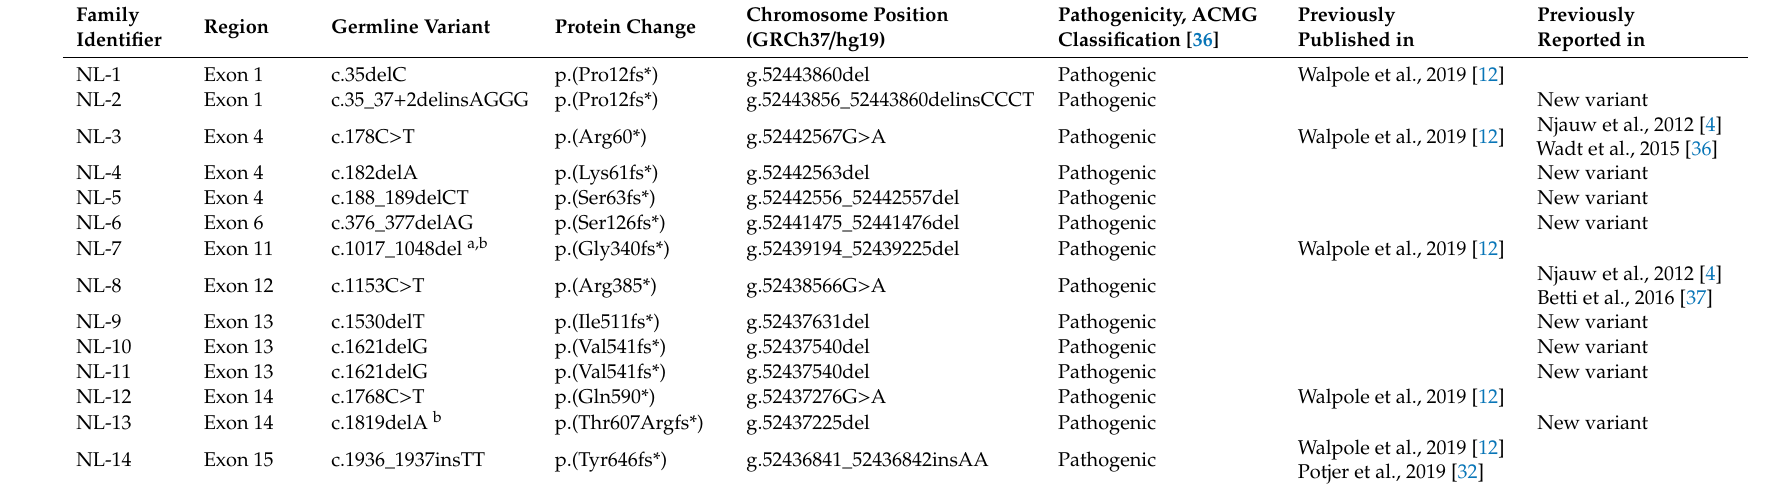
Table 2. Germline BAP1 variants causing a truncated protein.